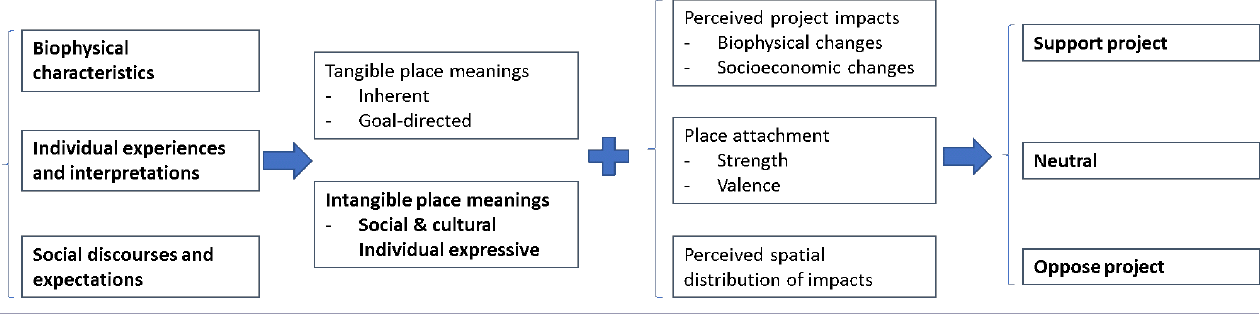
Fig. 1. Conceptual framework illustrating the relationship between place meanings and project support or